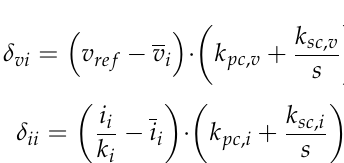
Figure 1. Conventional droop-based technique [12].